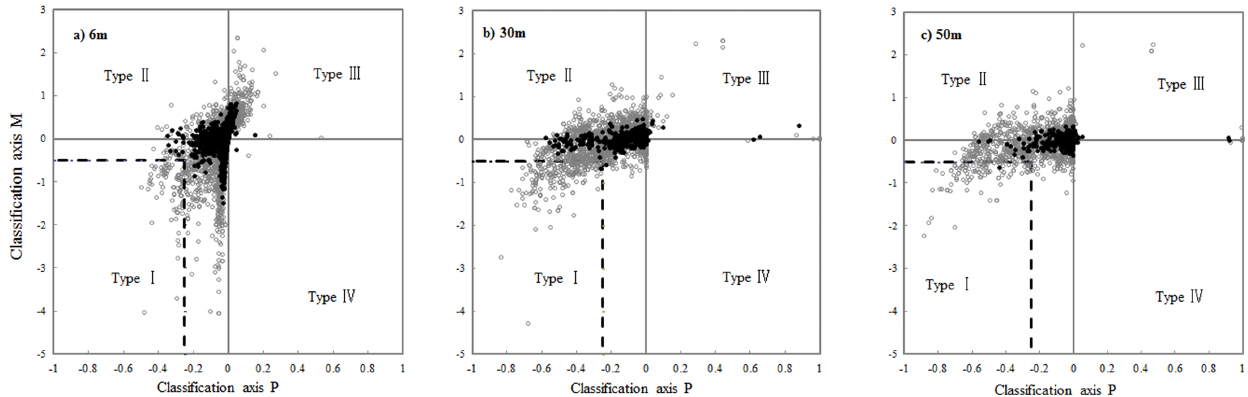
Figure 1. Classification of overall species associations at 6-, 30- and 50 -m scale. Allocation of overall species associations of 2,550 species pairs based on the classification axes defined in equation (1) and (2). The grey circles indicated the significant associations (i.e., significant departure from the null model by K 12 and D 12 ).